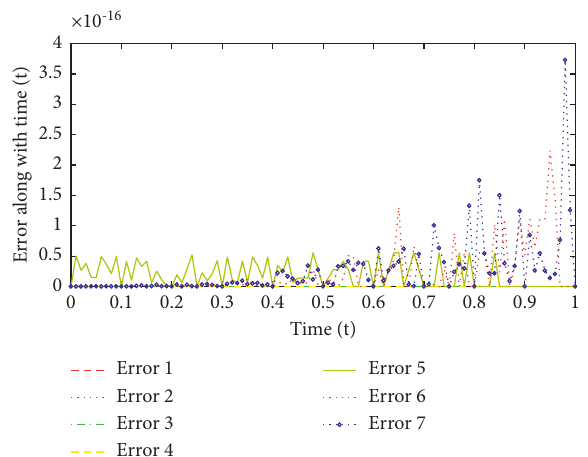
Figure 4: The error of the generator system solution for θ � sin t .